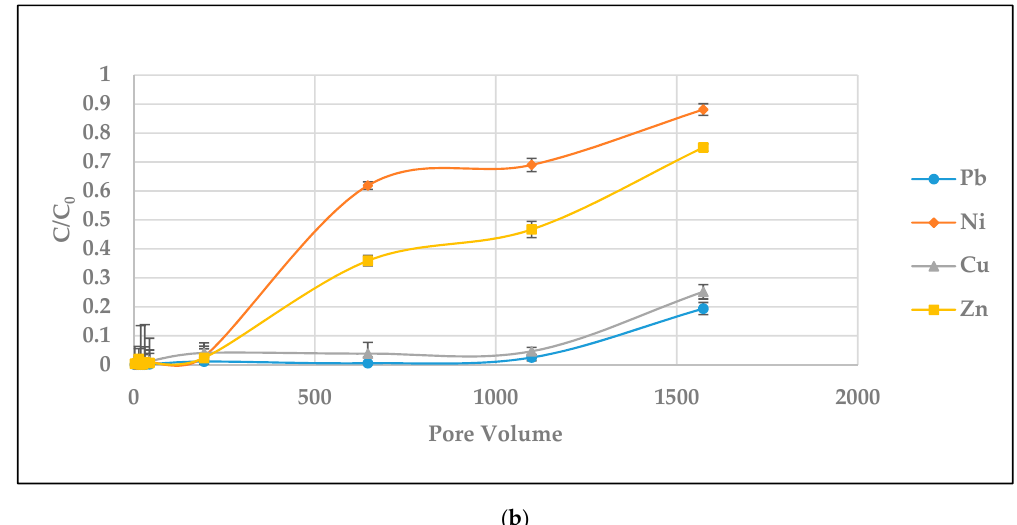
Figure 4. Percentage removal ( a ) and breakthrough curve ( b ) of the four metals by pine bark amended filters as a function of pore volume. AF stands for amended filter. C and C 0 are the effluent and influent metal concentrations, respectively.